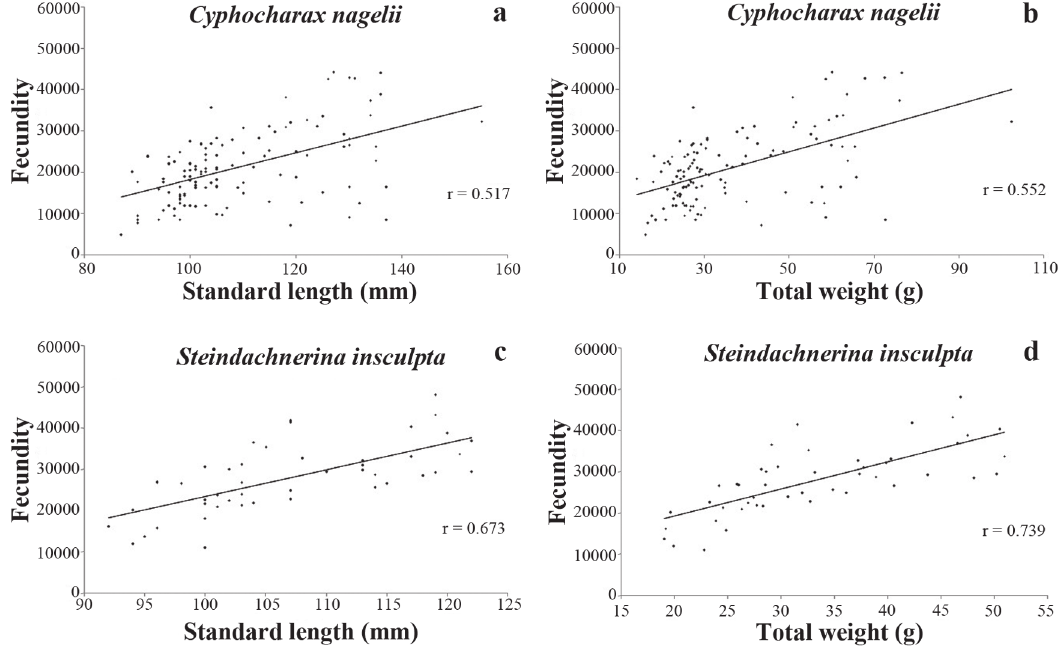
Fig. 6. Fecundity-standard length (mm) and fecundity-total weight (g) relationships to both studied Curimatidae